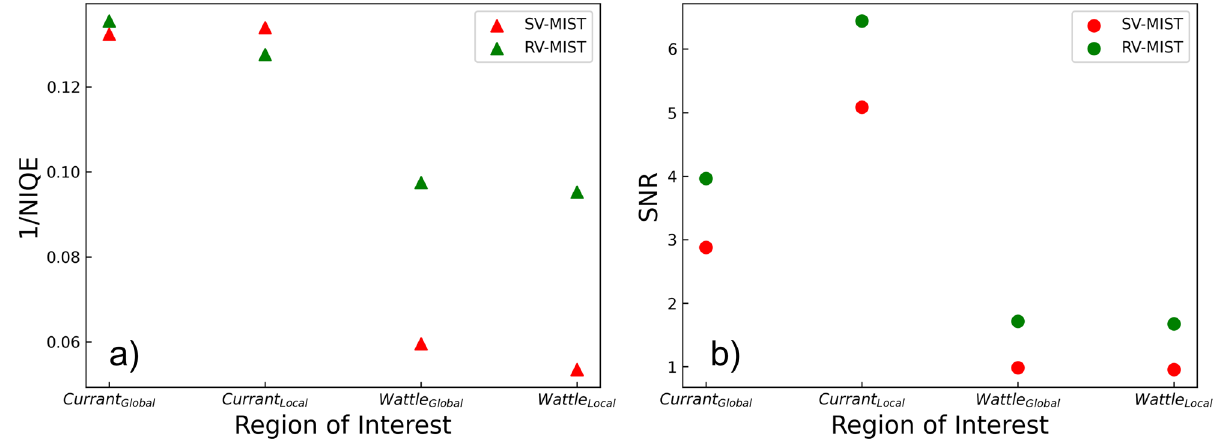
Figure 7. Image quality metrics, ( a ) reciprocal of the NIQE and ( b ) SNR, of the reconstructed effective diffusion coefficients using Alloo et al. ’s 42 approach (denoted by the red “SV-MIST” label), and that presented within this study (denoted by the green “RV-MIST” label). Subscript “ Global ” and “ Local ” denote the region of interest used for calculations; these are indicated in Figs. 3f and 5f for the wattle flower (wattle) and red currant (currant),